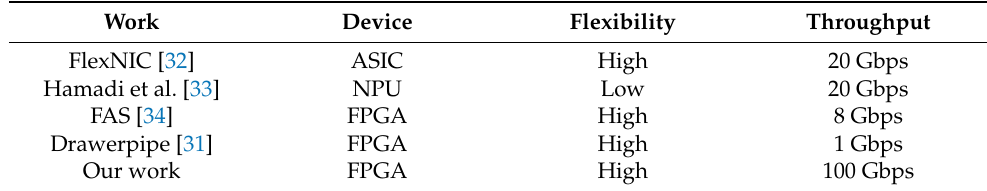
Table 1. Comparison with other related